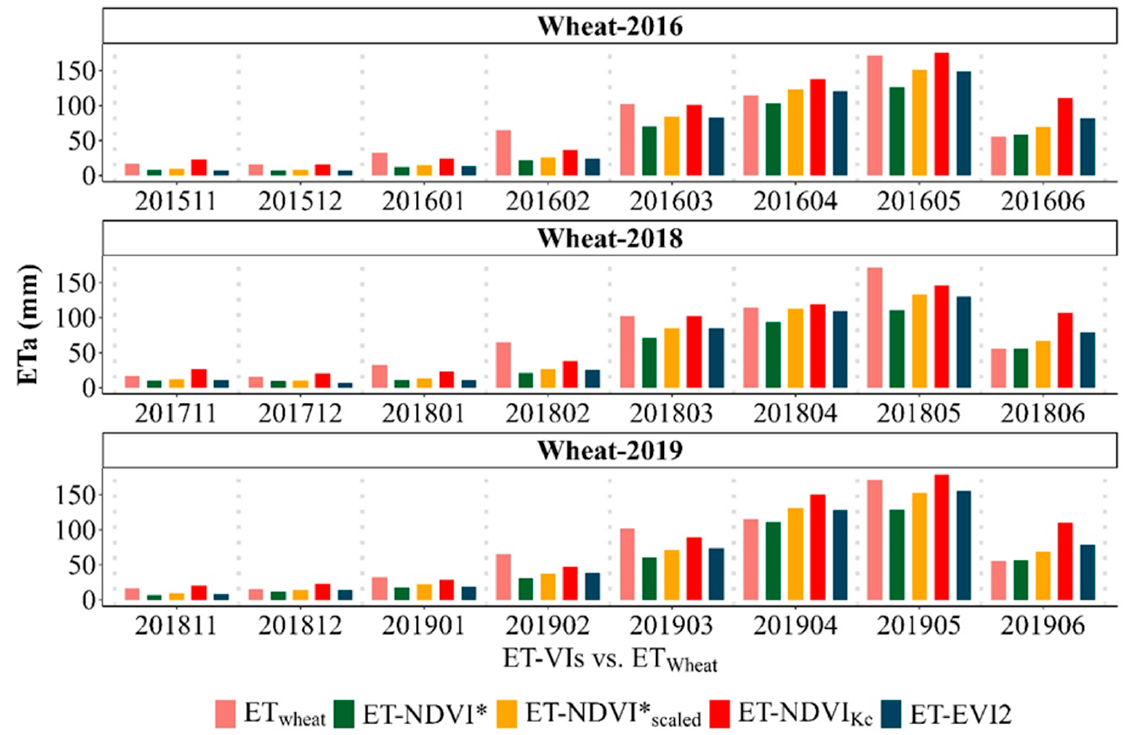
Figure 6. Comparison of monthly ET-VIs in three growing seasons with reported long-term monthly ET wheat .